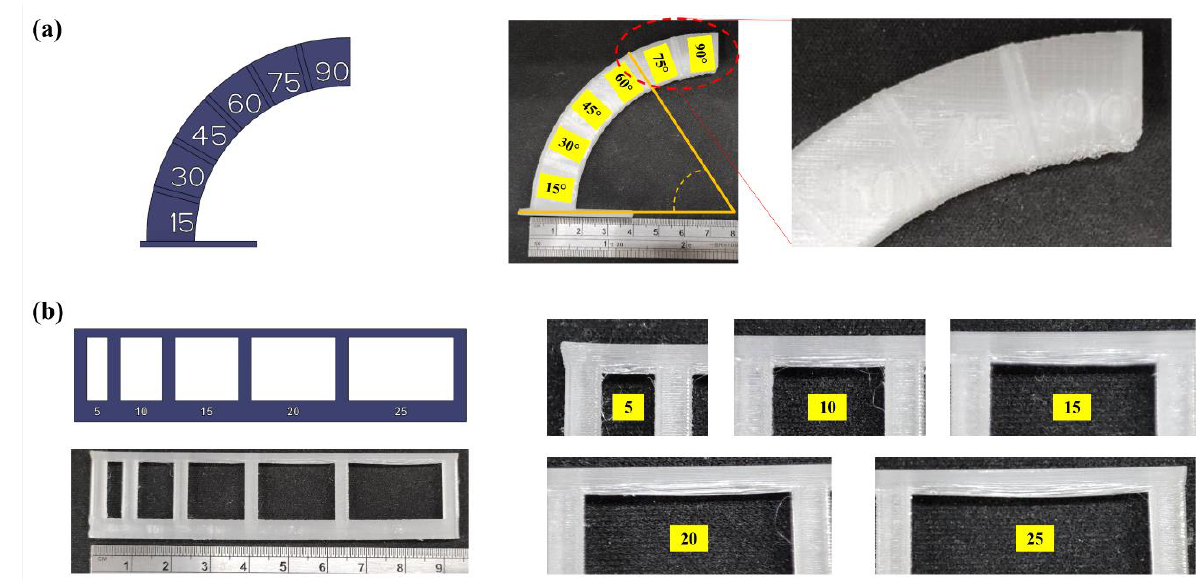
Figure 1. ( a ) Overhang angle and ( b ) Bridge distance for PETG material.